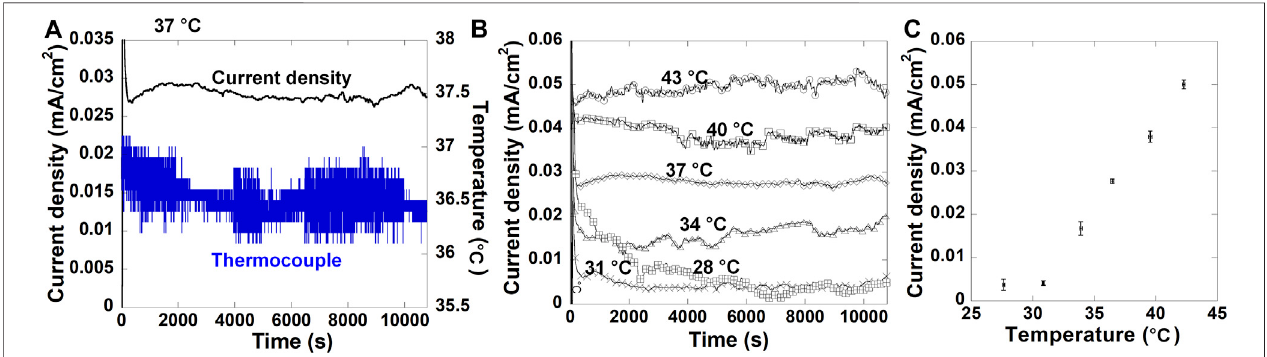
FIGURE 3 | Potentiostatic measurements of mirror-polished Ti6Al4V in 2 M HCl at − 510 mV vs. SCE for 3 h (A) with thermocouple record at 37 ° C, (B) at different temperaturesand (C) therelationshipbetweentheanodicsteadystatecurrentdensityandtemperatureintheparallelexperiments.Thevalueswerechosenfrom4,000 s to 10,800